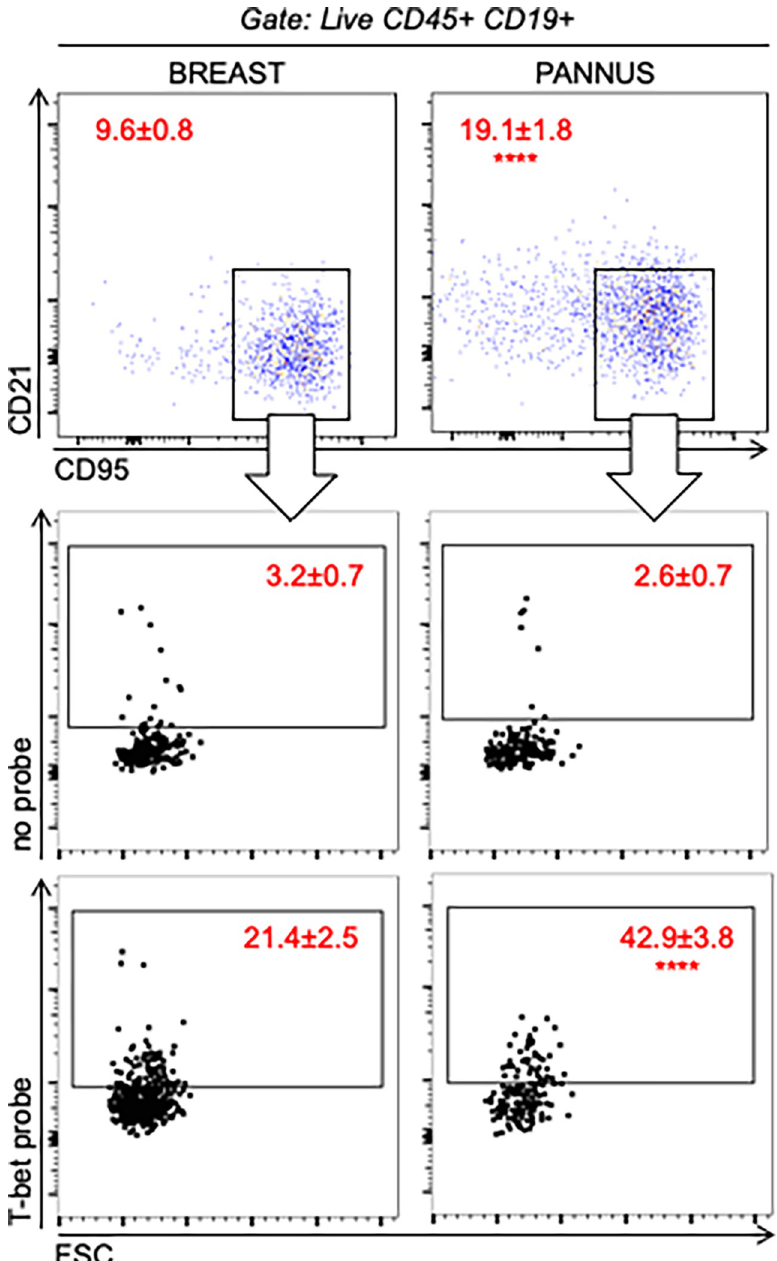
Fig 2. Higher frequencies of CD21 low CD95+, T-bet+ B cells in pannus versus breast SVFs. Unstimulated SVFs were membrane stained with Live/Dead detection kit and anti-CD19/CD21/CD95 antibodies. Top. Frequencies of CD21 low CD95+ B cells (means ± SE) in SVFs from breast (n = 10) and pannus (n = 10) donors are shown in red. Bottom. Detection of T-bet+ in CD21 low CD95+ B cells. Means ± SE of mRNA expression are shown in red. Negative controls (no probe) are also shown. Mean comparisons between groups were performed by Student’s t test (two- tailed). **** p <